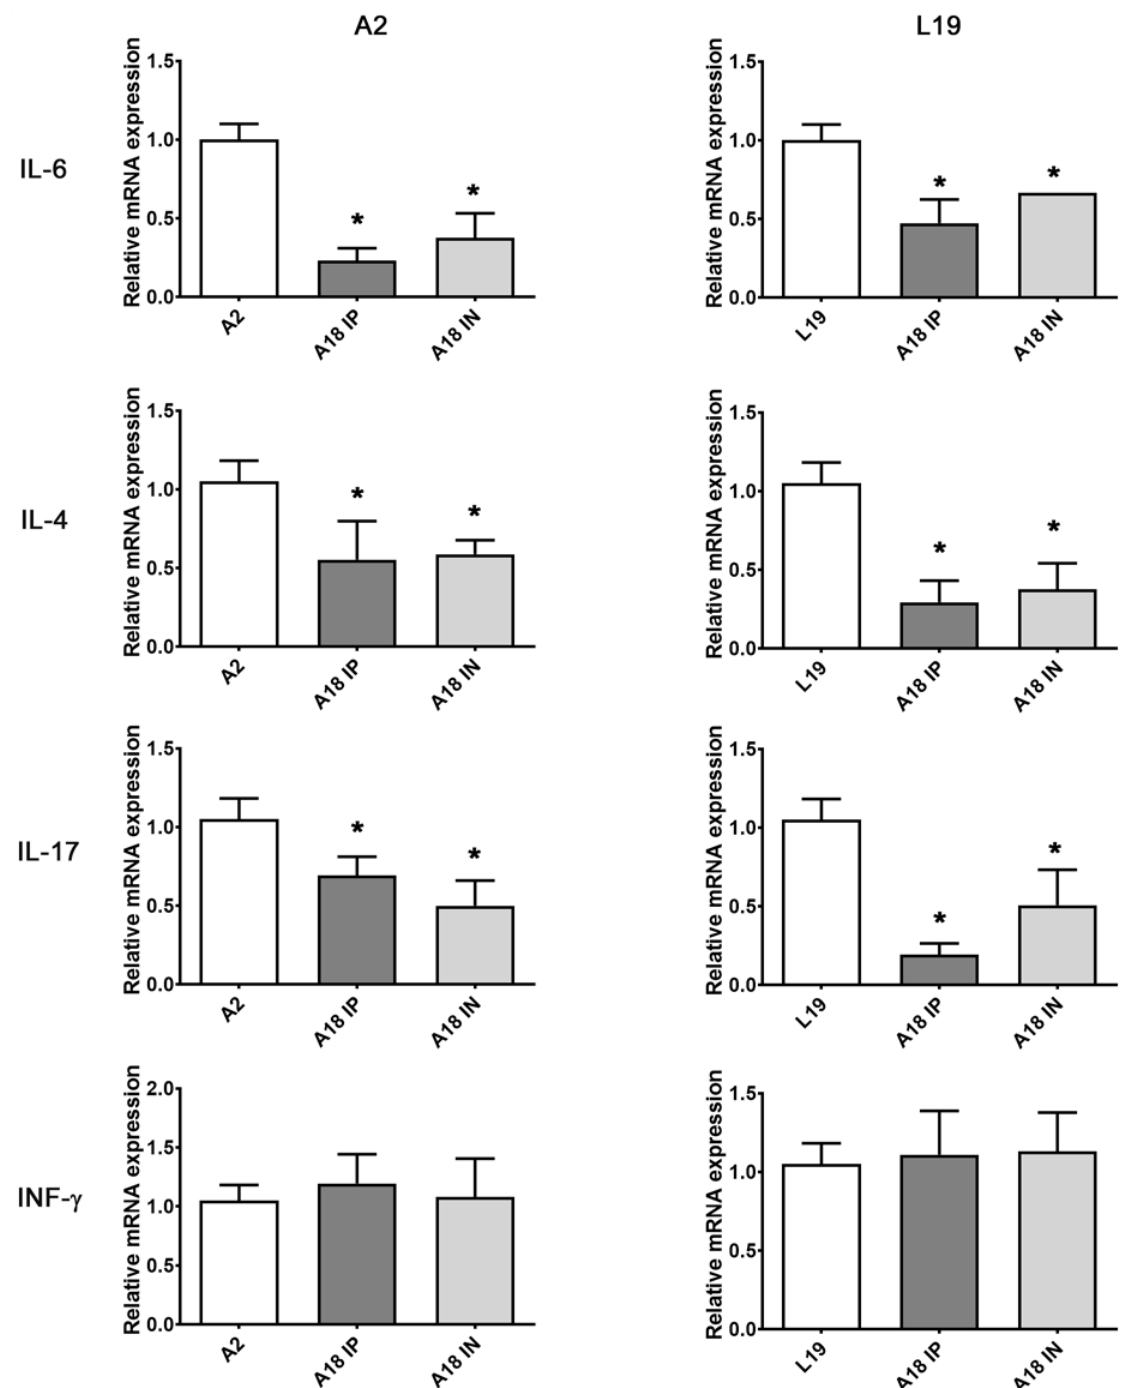
Figure 6. Cytokines gene expression determined by real-time PCR. Pulmonary cytokines expression was assessed on day 8 p.i. and the data were analyzed using the 2 −ΔΔCt formula. Actin was used as an internal for determination of gene expression. Data show mean ± SD from n = 3 mice/condition. * Significantly different from RSV-infected mice ( p -value <